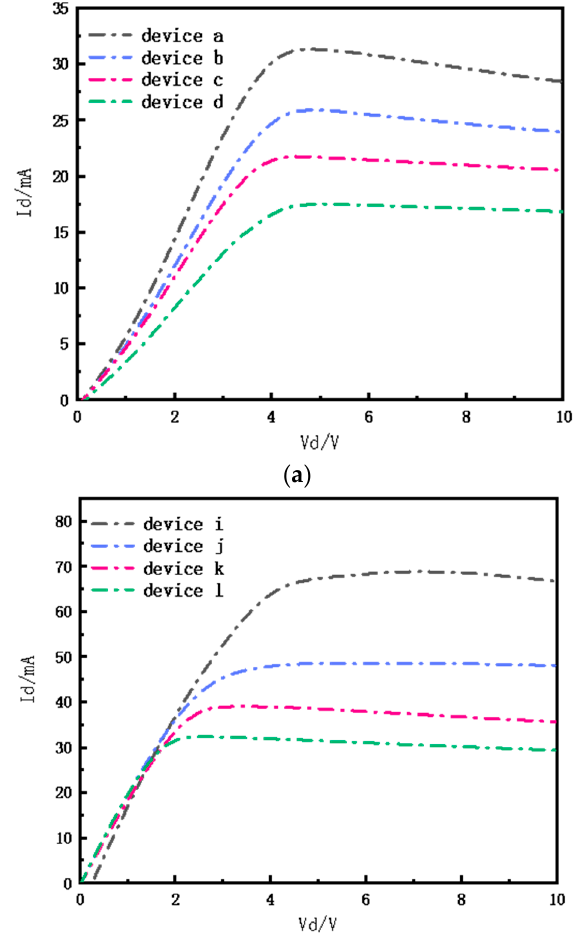
Figure 11. ( a ) Output characteristics of conventional structure devices with Lgd of 7/11/15/19 μ m. ( b ) Output characteristics of ring-gate structure devices with Lgd of 7/11/15/19 μ m.